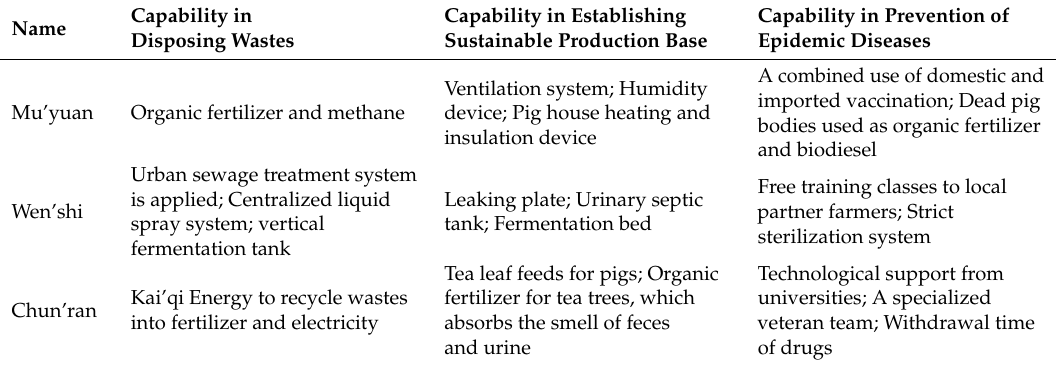
Table 3. Dynamic capabilities of focal case